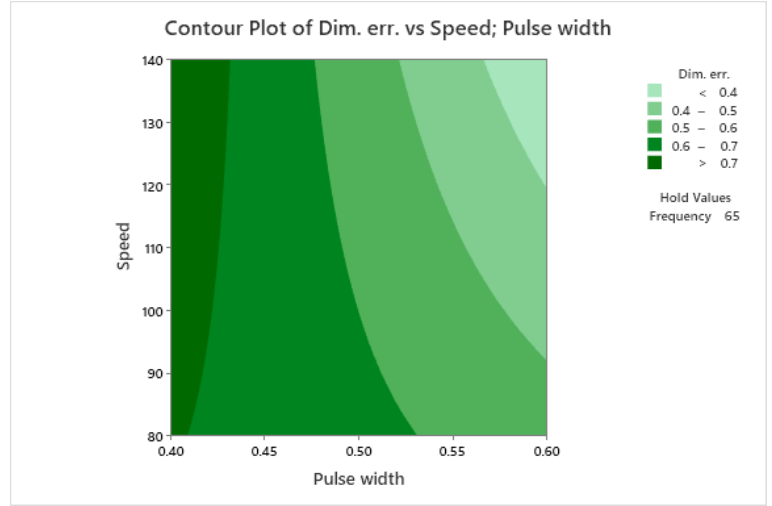
Figure 6. Contour plot of dimensional error vs. pulse width and speed.